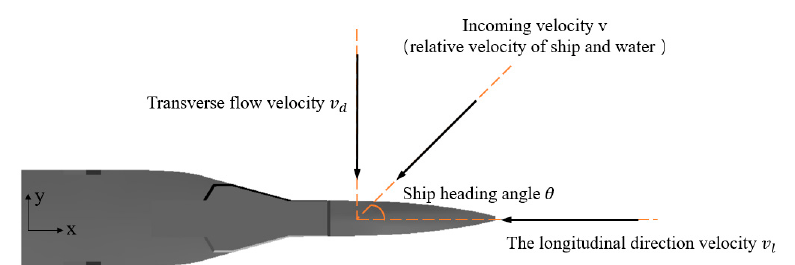
Figure 3. Decomposition of incoming flow velocity.